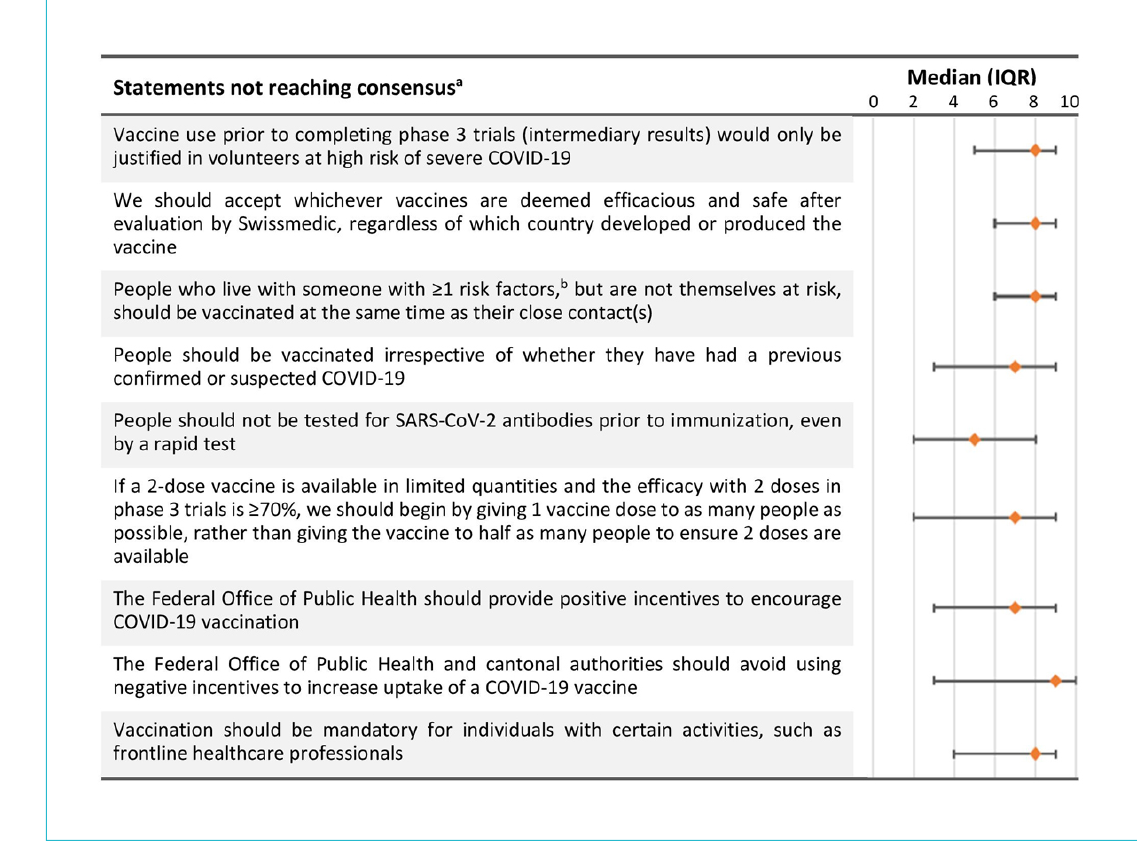
Figure 2: Key recommendations not reaching consensus. Agreement scores were on a scale from 0 (complete disagreement) to 10 (complete agreement). The orange diamond is the median score, with horizontal bars representing the interquartile range (IQR). a Consensus was de- fined as a median agreement score of ≥8 out of 10, with a lower IQR bound ≥7. b Risk factors as defined by the Swiss Federal Office of Public Health at